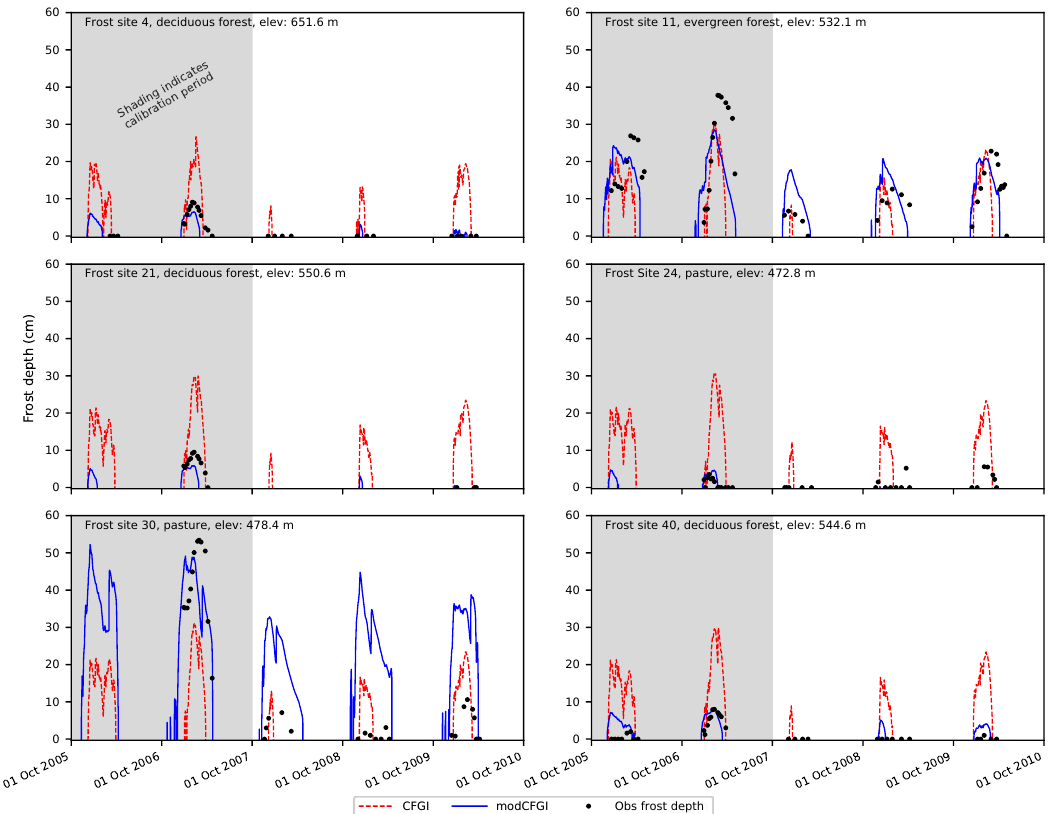
Figure 7. Observed frost depth compared against simulated (CFGI and modCFGI) frost depth at all six selected frozen ground test sites within the W-3